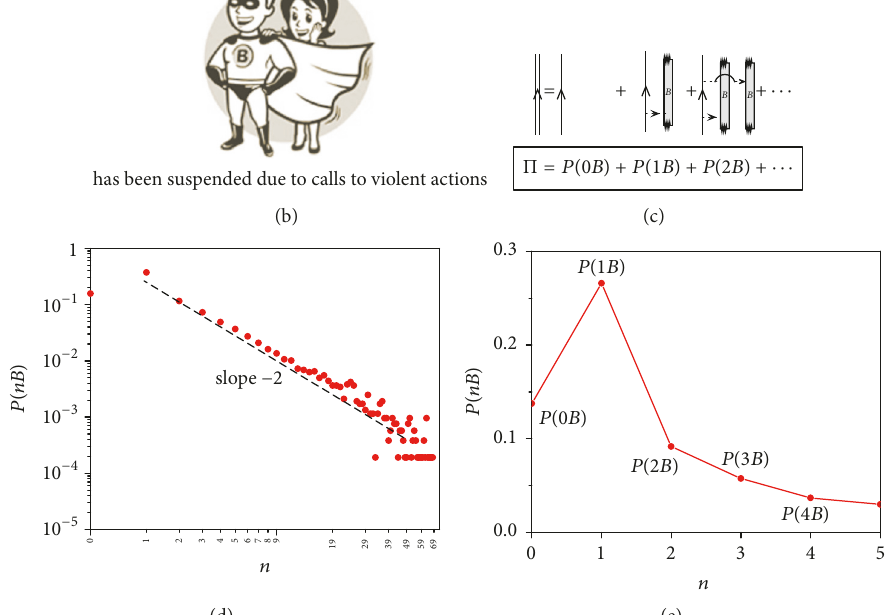
Figure 1: Individuals’ online trajectories . (a) Schematic of group-joining in the complex pro-ISIS online space https://www.vk.com which comprises a mix of individuals (colored squares), groups (clouds), and content (examples show some less explicit postings). One observed sequence of joining events is listed as an example using abbreviations 𝐵 and 𝐴 for the joining of a “future-ban” or “no-future-ban” group, respectively. (b) Snapshot from VKontakte showing the measurable event of a group or individual getting banned. (c) Exact diagrammatic expansion for the probability (i.e., risk) Π which is the probability that any given individual in our study will eventually develop a sufficiently high level of pro-ISIS support that he/she violates VKontakte’s rules against promoting pro-ISIS violence and hence his/her account gets banned. 𝑃(𝑛𝐵) is the probability that his/her account will eventually get banned and he/she joins exactly 𝑛 future-ban ( 𝐵 ) groups prior to this banning. Hence by definition, 𝑃(𝑛𝐵) = 0 for individuals whose accounts do not get banned. The probability propagator for a future-ban ( 𝐵 ) group is shown as a gray strip. The expansion of the terms is shown both in terms of diagrams (top) and the corresponding mathematical expressions (below). (d) Log-log probability 𝑃(𝑛𝐵) , calculated from the empirical data by counting the fraction of individuals whose account eventually gets banned and who join exactly 𝑛 future-ban ( 𝐵 ) groups between Jan 1, 2015, and the instant his/her account gets banned (by definition, 𝑃(𝑛𝐵) = 0 for no-future-ban individuals since they do not get banned). Line with slope −2 is shown as a guide. (e) Same as (d) but over small n